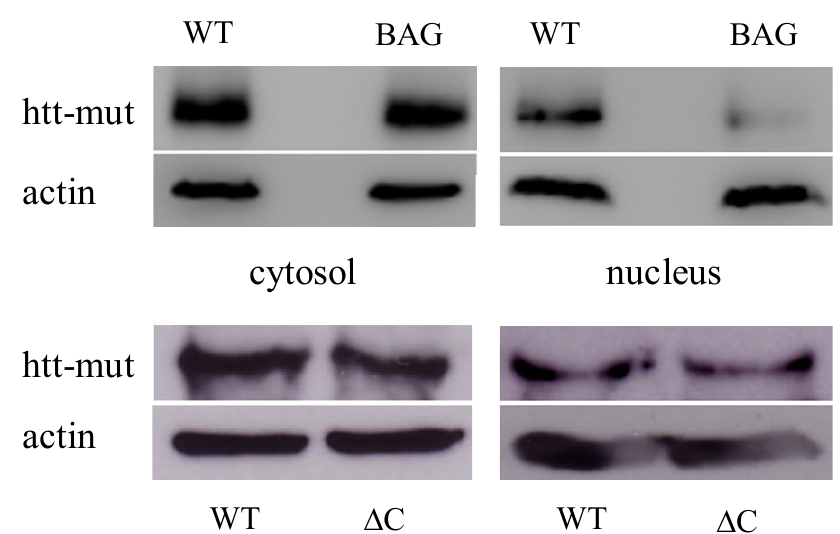
Figure 4 . BAG1 influences htt-mut subcellular